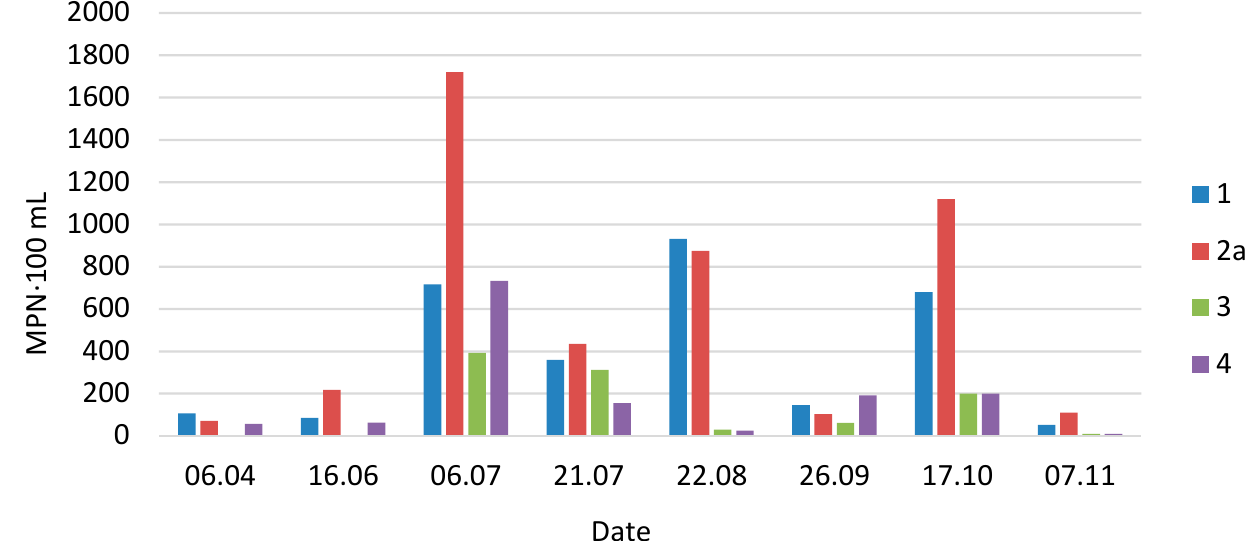
Figure 6. Variation in the number of E. coli cells in the SED-BIO system in the test period April– November 2016. The results are shown as MPN (most probable number) in 100 mL.